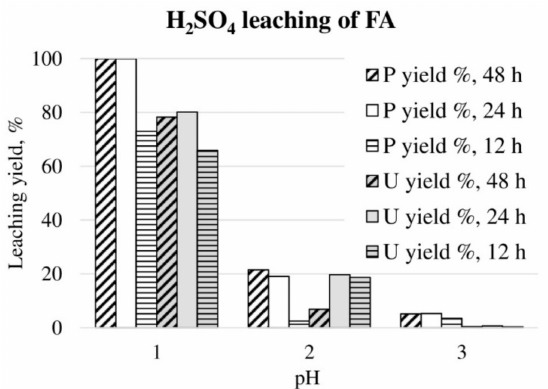
Figure 1. P and U leaching yields during H 2 SO 4 leaching of FA in di ff erent pH values for 12, 24 and 48 h, at 22 ◦ C